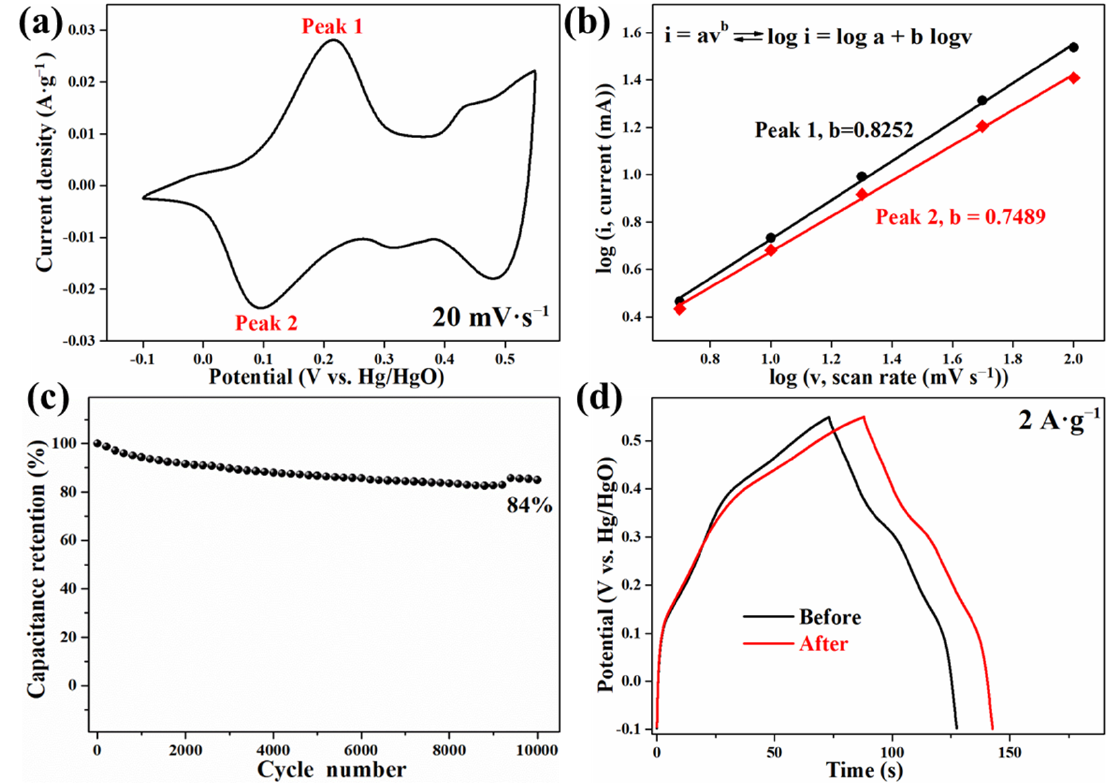
Figure 7. ( a ) The CV curve shows Peak 1 and Peak 2 to illustrate Figure 7b. ( b ) The plots of log (i) vs. log (v) for the redox current peaks; ( c ) Cycle performance; ( d ) GCD curves of CoSi before and after the calcination at 275 °C for 60